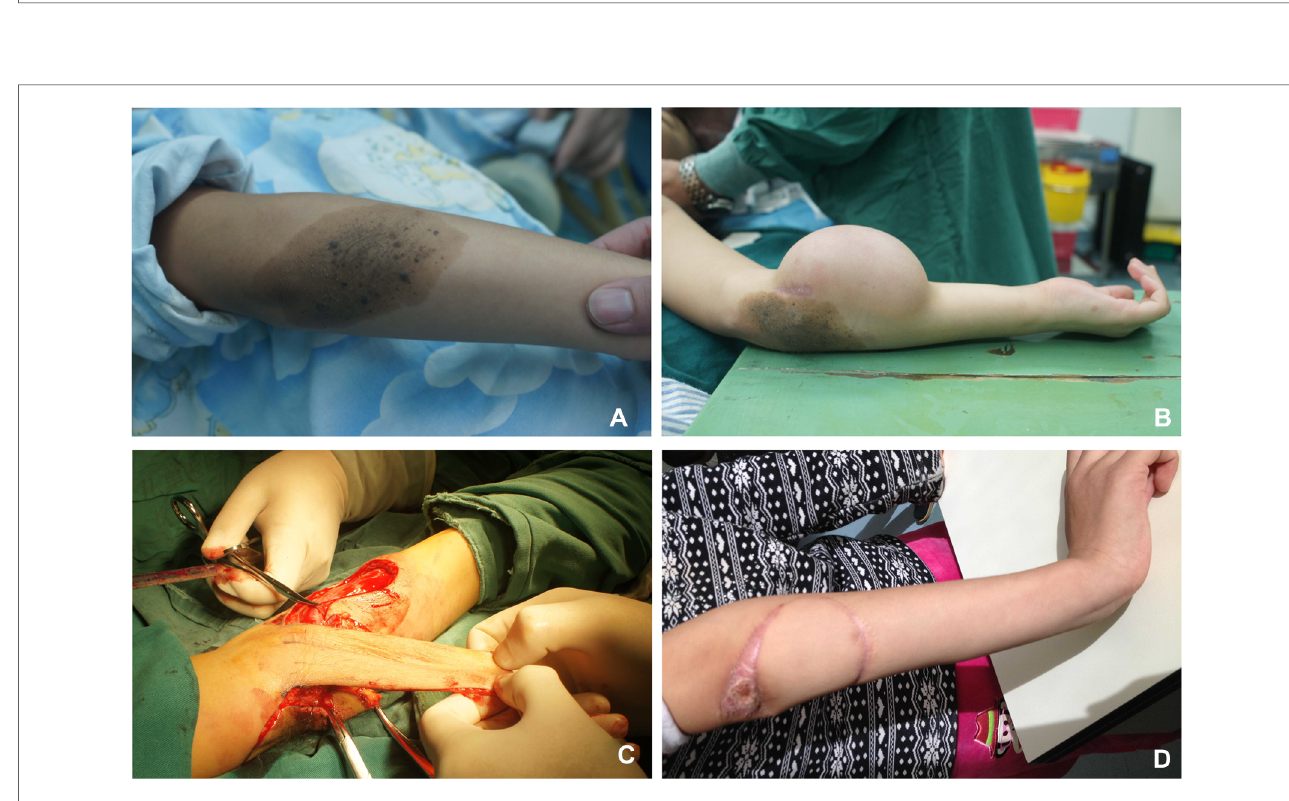
FIGURE 6 Case 1. ( A ) Upper limb moles. ( B ) Preoperative appearance of the expanded fl ap. ( C ) Flap resection during operation. ( D ) Postoperative appearance at follow-